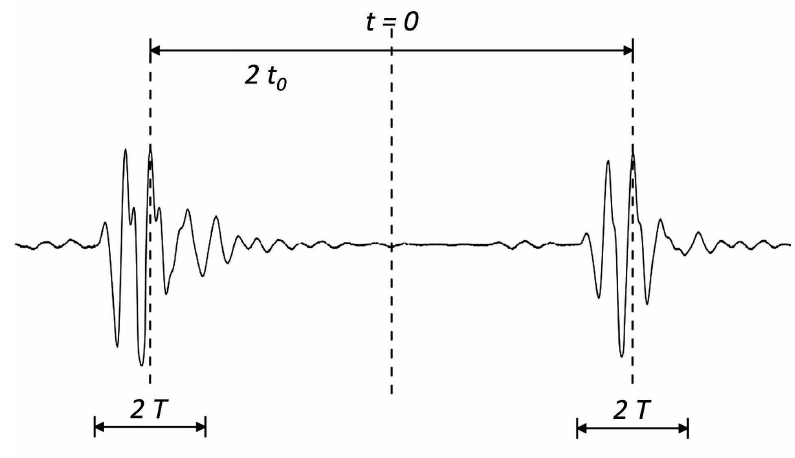
Figure 4. Two identical ultrasonic pulses with time delay of